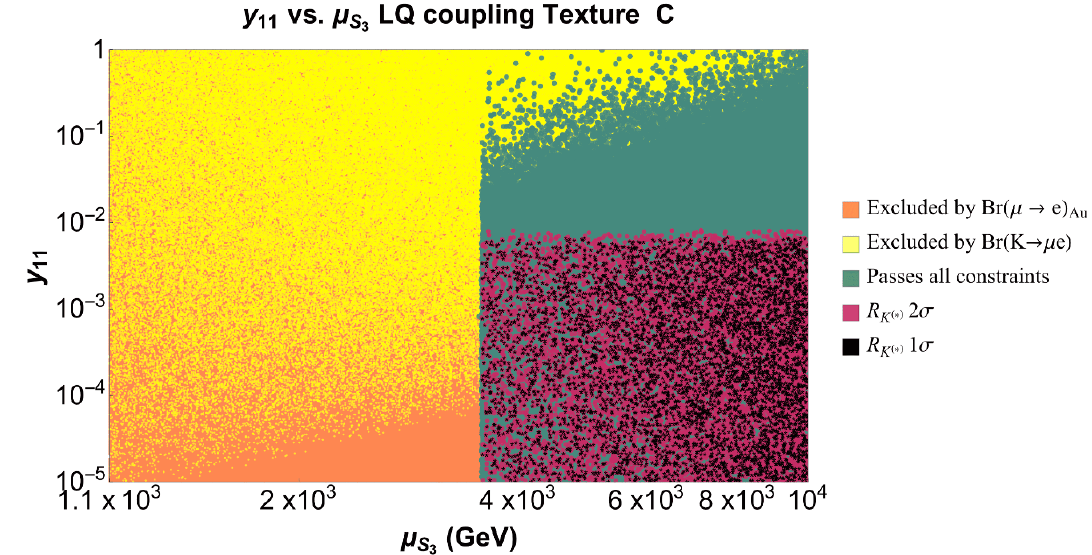
Figure 21 . Indicative plot of the allowed parameter space in the y 11 vs. m S plane, for leptoquark 3 coupling matrix Texture C. The teal region shows allowed parameter space, while the orange re- gion indicates parameter space excluded by constraints on Br( (cid:22) ! e ) Au , while the yellow region show parameter space excluded by Br( K ! (cid:22)e ). The black (pink) points indicate bounds on the parameters y 11 and (cid:22) S needed to explain the R anomalies to within 1(2) (cid:27) K ( (cid:3) ) 3